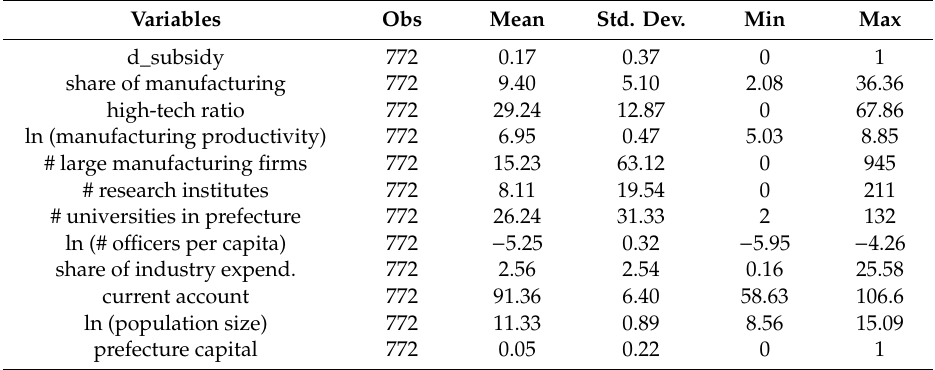
Table 1. Basic statistics of all cities (including Tokyo Wards) in Japan.